Question: Identify the chart type used in this figure.
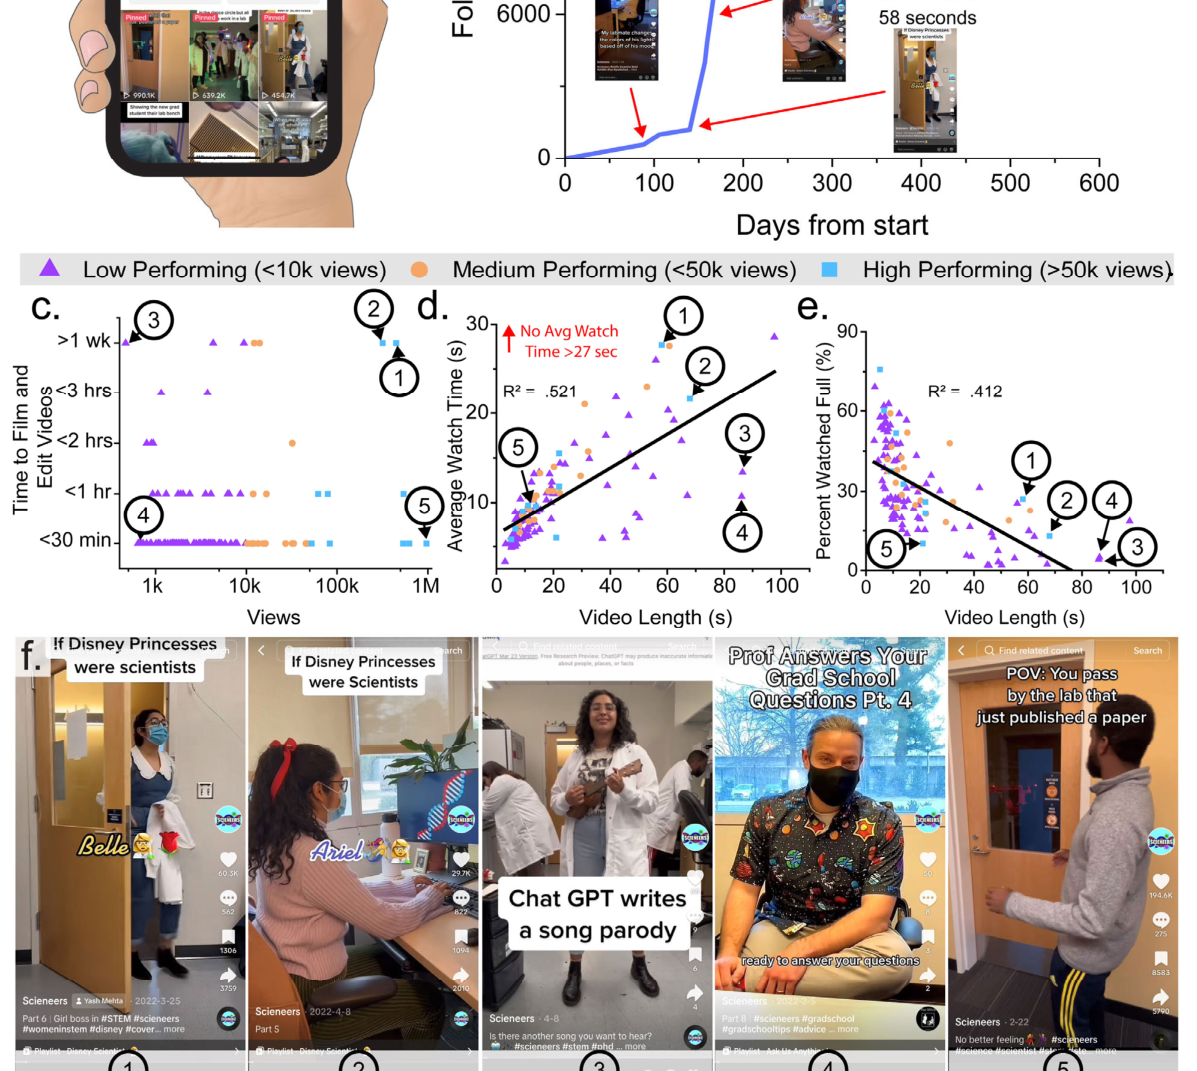
Answer: line